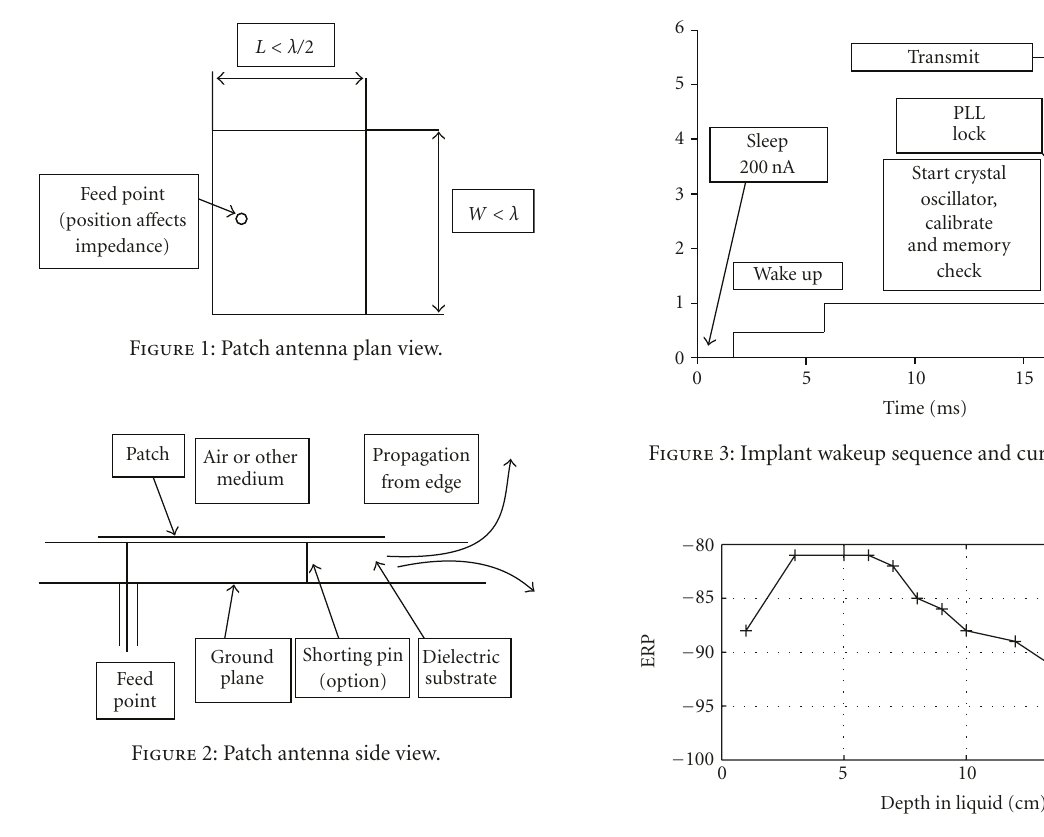
Figure 4: ERP versus Depth in liquid.